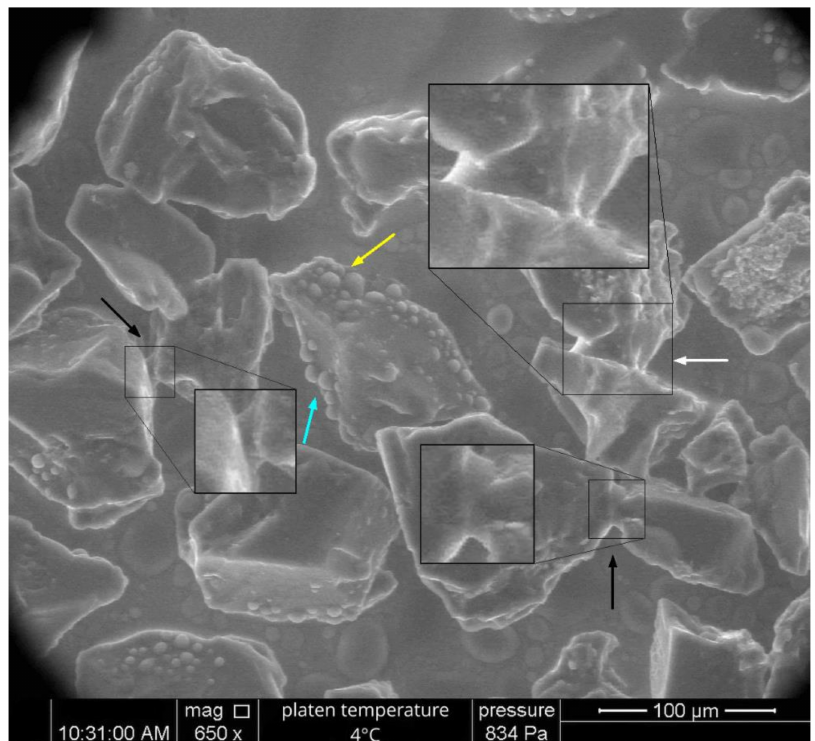
Figure 9. ESEM image of coal obtained during a wetting phase. The squares show magnifications of zones containing menisci. The arrows indicate significant menisci or water droplets that are discussed in the analysis of this